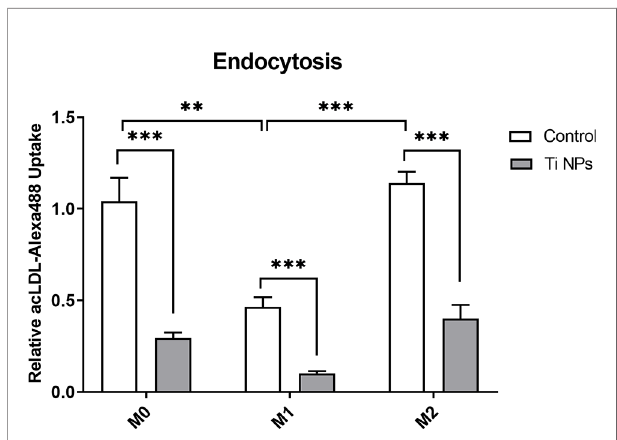
FIGURE 3 | Titanium nanoparticles signi fi cantly suppress scavenger- receptor-mediated endocytosis in all types of macrophages. M0, M1 and M2 macrophages were cultured for 6 days. acLDL-Alexa488 was added at a concentration of 2 µg/mL to macrophages for 30 minutes at 37°C. Ligand internalization was quanti fi ed by fl ow cytometry: n = 7. Error bars indicate the means standard error of the geometric mean normalized to non-stained cells relative endocytosis **p < 0.01, ***p <